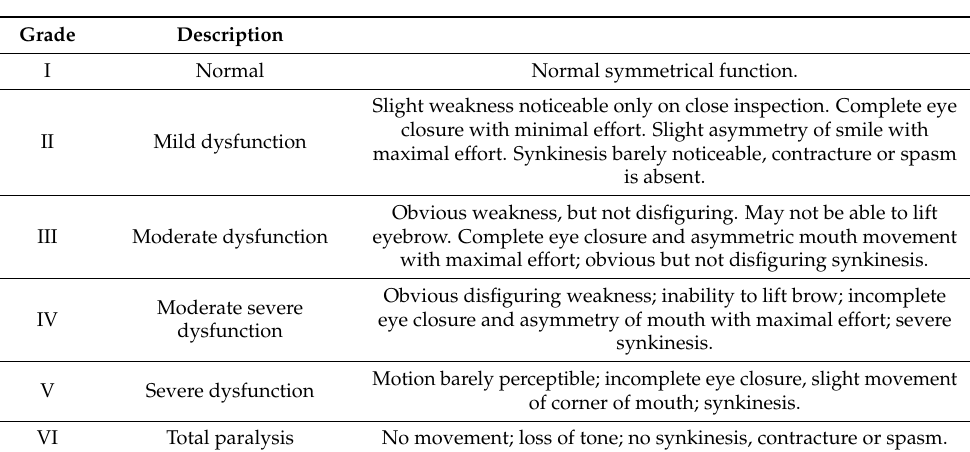
Table 2. House–Brackmann classification of facial nerve